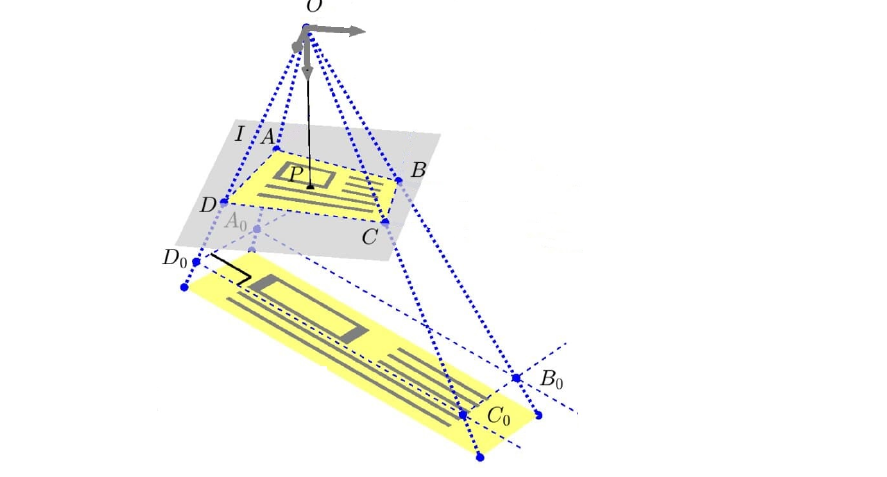
Figure 3. The captured image of the rectangular document in a pinhole camera model.